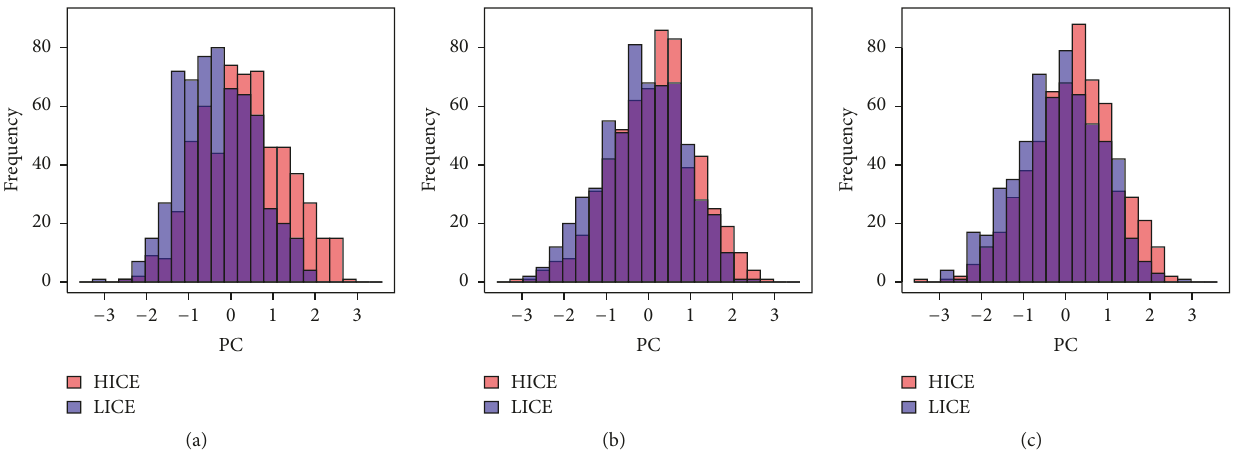
Figure 8: Histograms of corresponding PC time series of geopotential height at the three model levels: upper level (a), middle level (b), and lower level (c). HICE(in red) and LICE(in blue) correspond to themodel runs with high and low Arctic sea-ice-cover conditions, respectively. Overlap in the frequency of occurrence between HICE and LICE is marked in